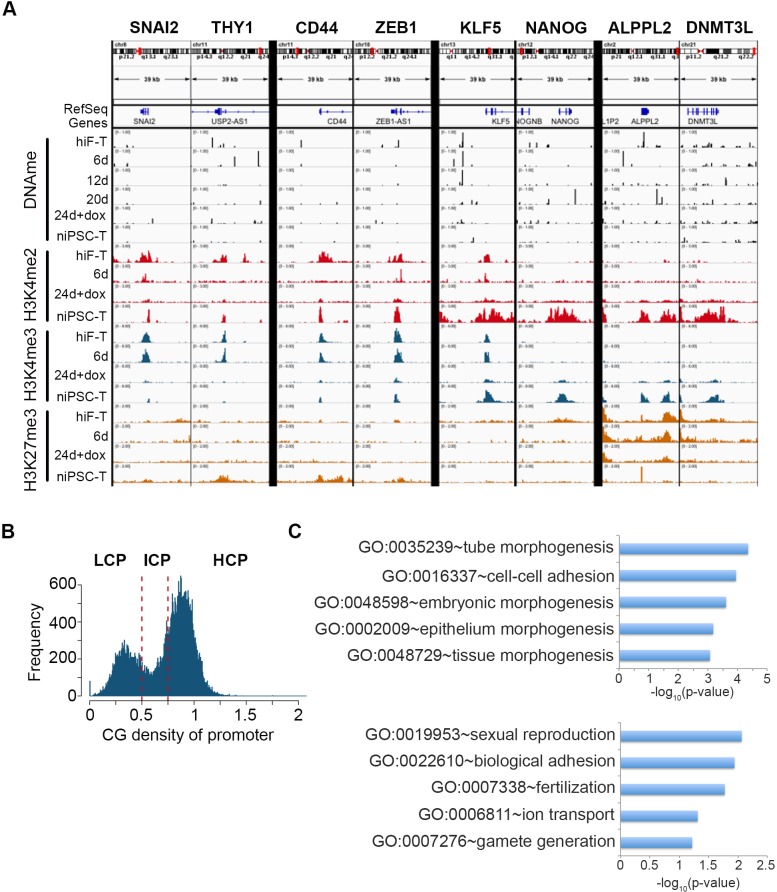
Epigenetic changes of representative genes during naïve reprogramming path.(A) Base-level visualization of DNA methylation and histone modifications in the promoter regions of representative genes. (B) Classification of genes by the CG ratio in their promoter. (C) Enrichment of p-value of representative GO term of clusters based on different CG ratios in promoters as shown in Figure 6B.